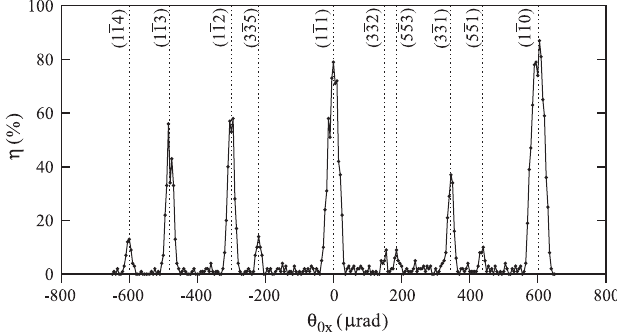
FIG. 11. Simulation results for the efficiency of the proton beam deflection by the bent crystal as a function of the angle ¼ 850 (cid:6) rad (cid:1) 0 . (cid:1) 0 x y